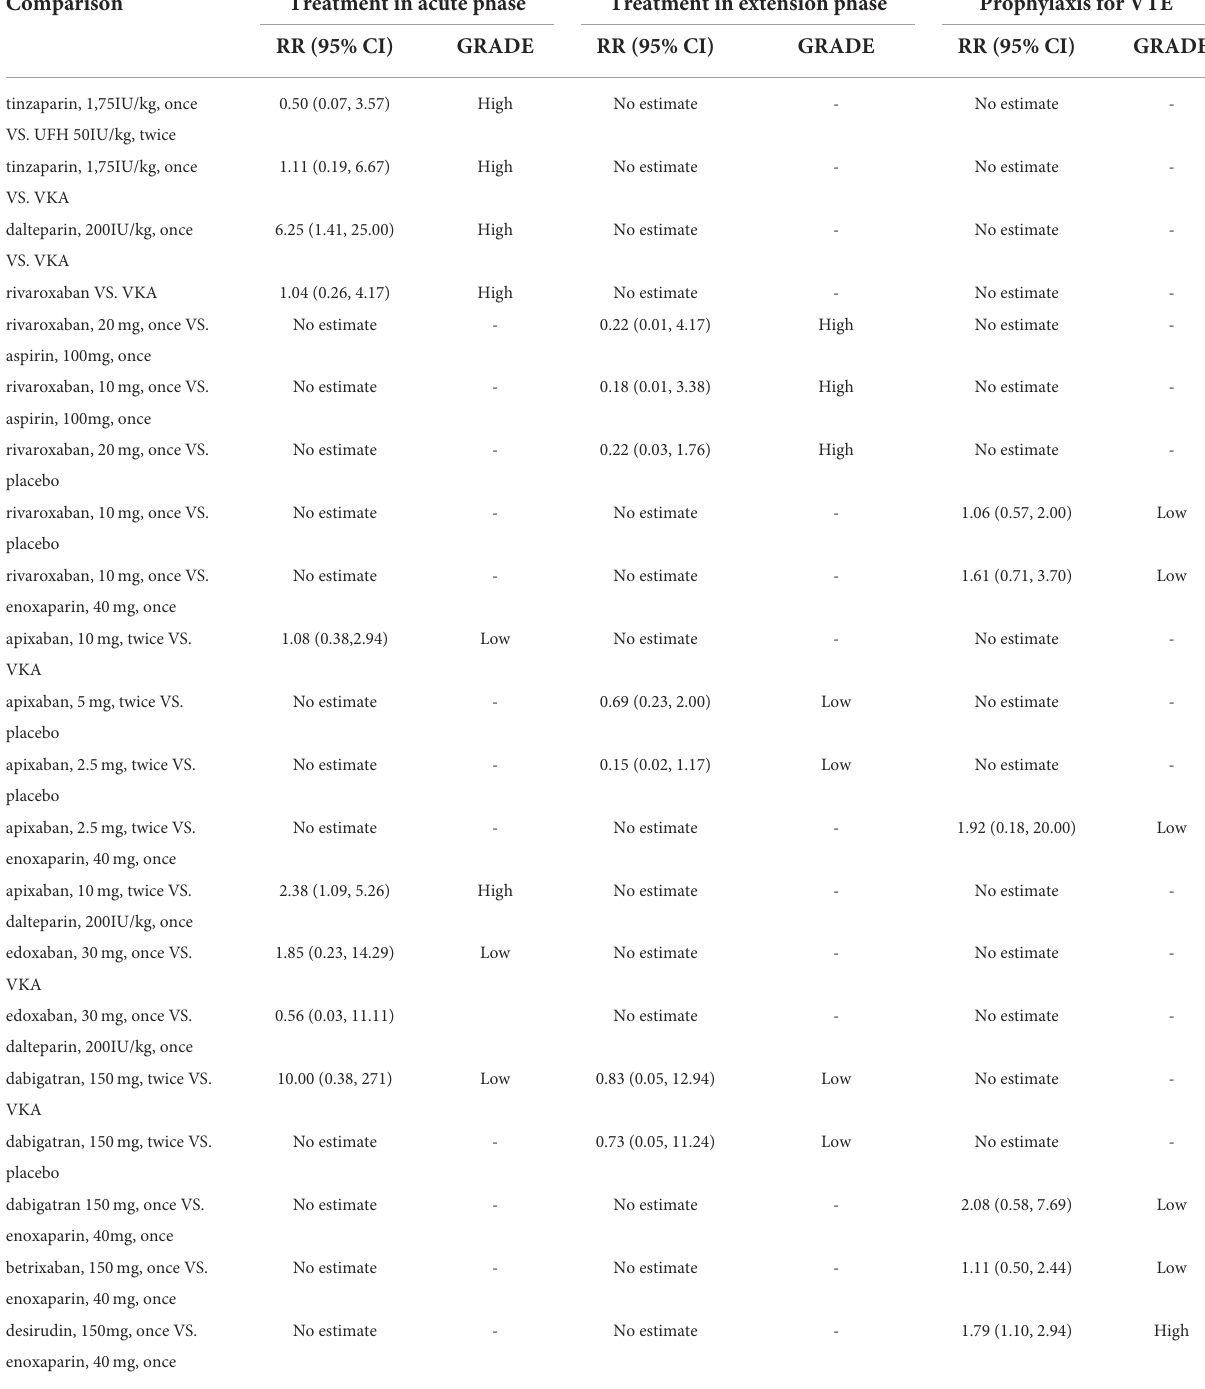
TABLE 2 Direct comparisons and the rating the quality of evidence by the GRADE approach.